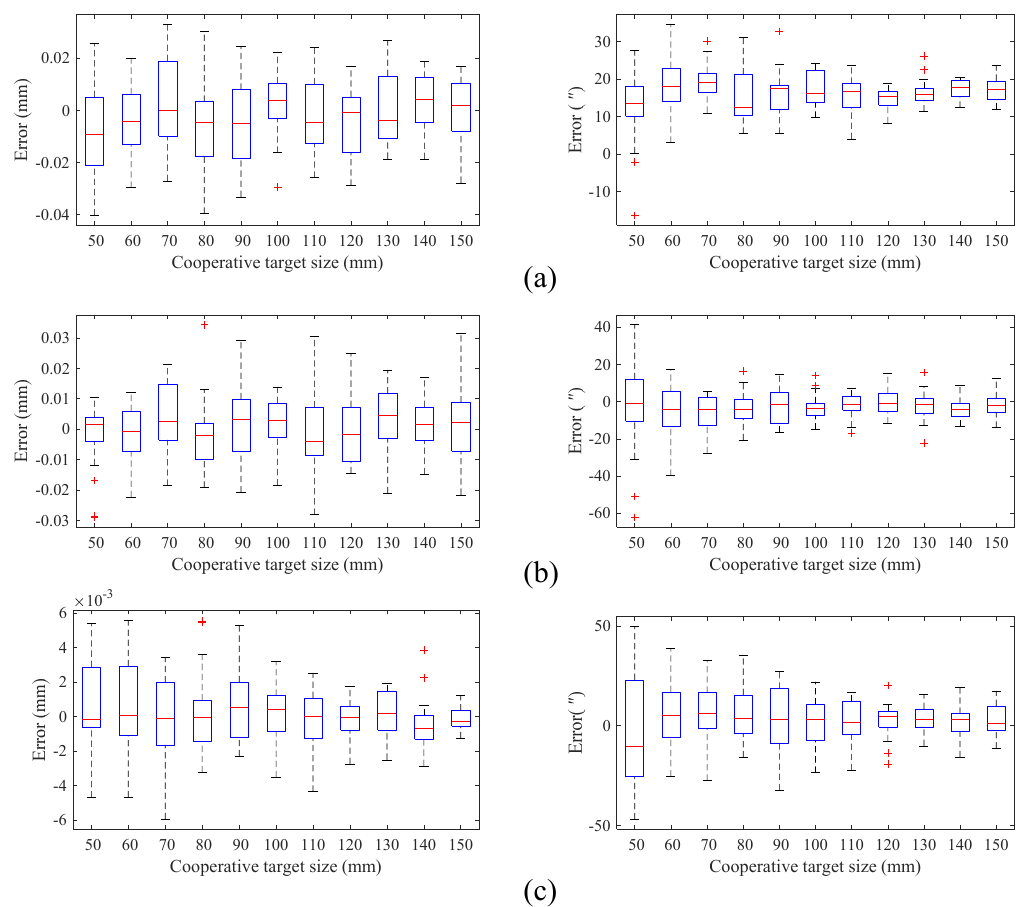
Figure 7. Simulation results for different cooperative target sizes. Measurement errors in ( a ) the x − axis direction; ( b ) the y − axis direction; ( c ) the z − axis direction.